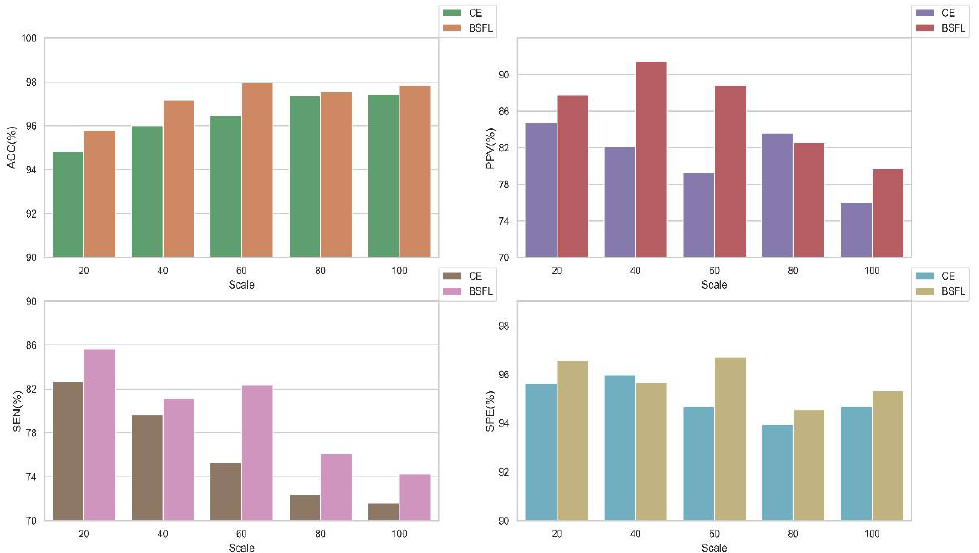
Figure 13. The average performance bar of the model with and without the algorithms in different scales under inter-patient paradigm. BSFL: Borderline-SMOTE algorithm and focal loss function. CE: cross-entropy loss function.